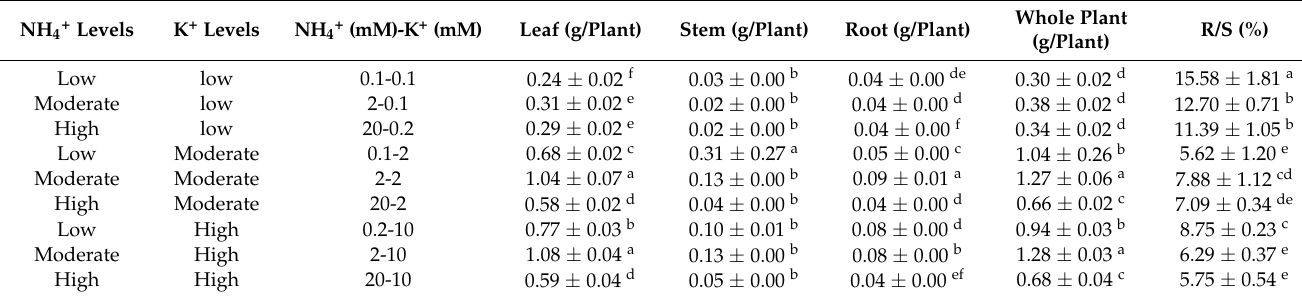
Table 1. Dry weights of leaves, stems, and roots, and root to shoot ratio (R/S) of tobacco seedlings under different NH 4+ and K + concentrations.